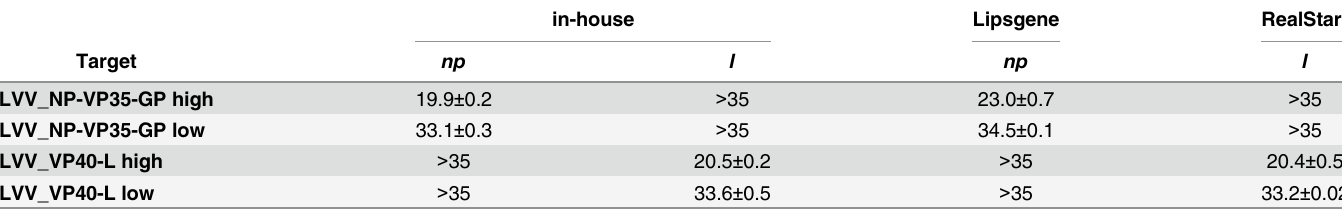
Table 2. Evaluation of the HIV-EBOV RNA standard by quantitative RT-PCR.